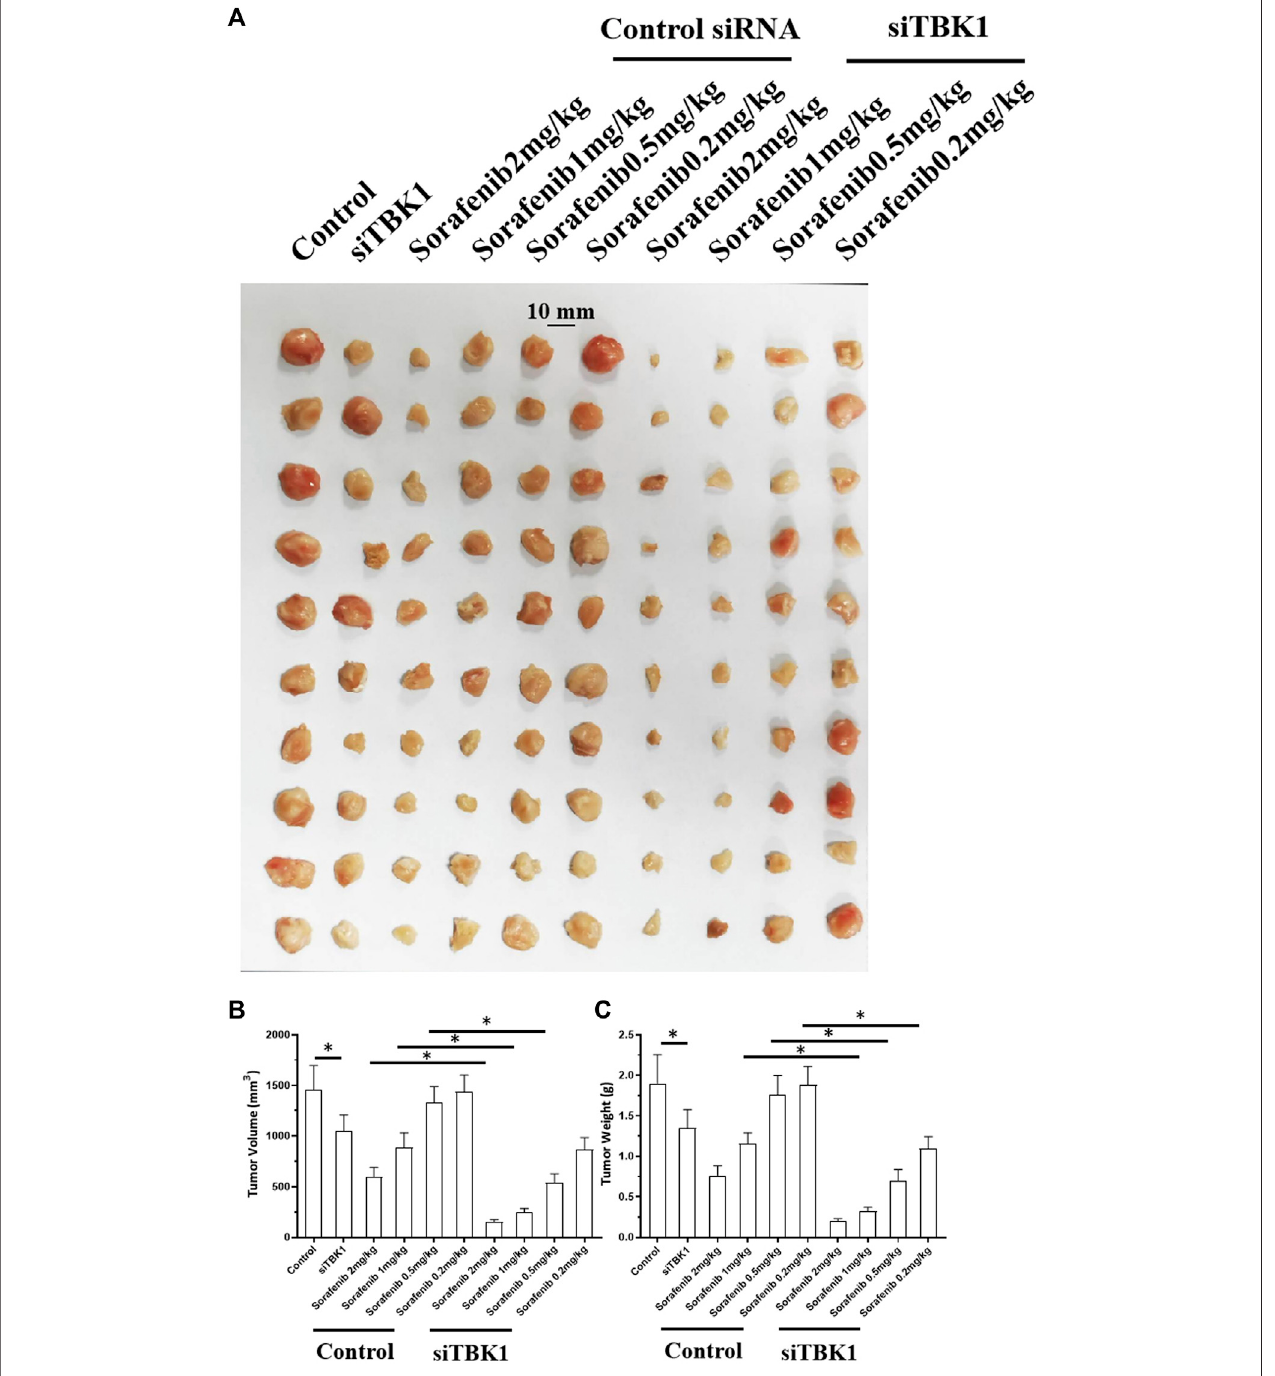
FIGURE 6 | siTBK1 enhances the sensitivity of MHCC97-H cells to the molecularly-targeted drug, sorafenib After transfection of siTBK1 in MHCC97-H cells, the cells were inoculated into nude mice, and the nude mice were treated with sorafenib by oral gavage. Afterward, tumor tissues were collected to determine their volume and weight. Results are displayed as photos of tumor tissue, tumor volume, and tumor weight. p p < 0.05.